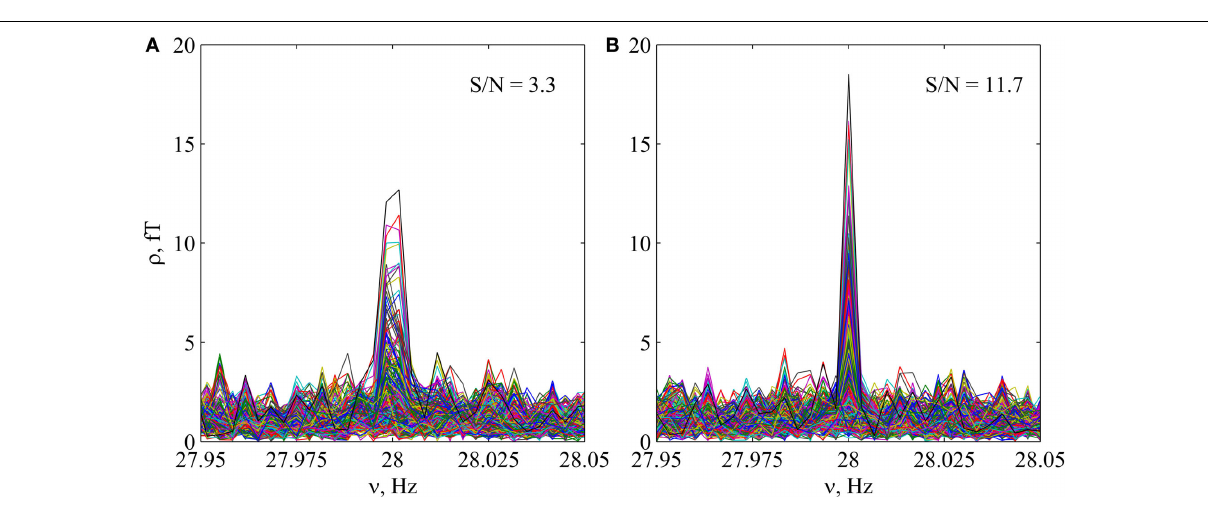
T = 300 − 0 . 017s. It can be concluded, that a negligible lost of information significantly increases the signal to noise ratio (S/N), leading to much higher coherence. More precise solution of the inverse problem can be obtained after such